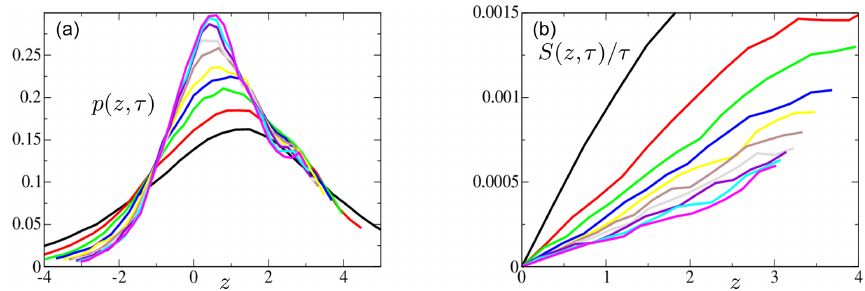
Figure 3. The pdf p(z,τ) (a) and the symmetry function normalized by the averaging time S(z,τ)/τ (b) as a function of z for different averaging times τ (see caption and legend of Fig. 1); data are for case PSG, res 0.5 ◦ , 1993–2016, res 6h.